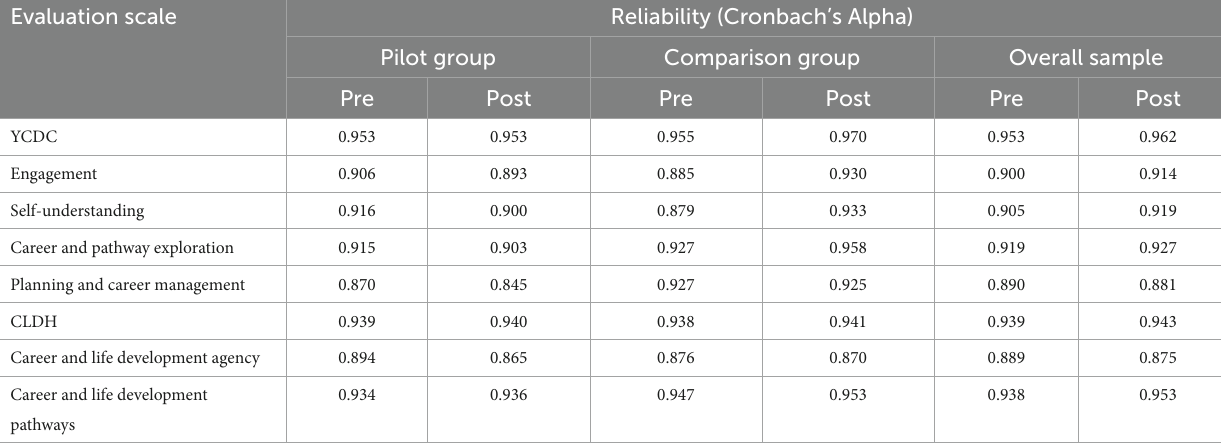
TABLE 3 Reliability estimates of career-related